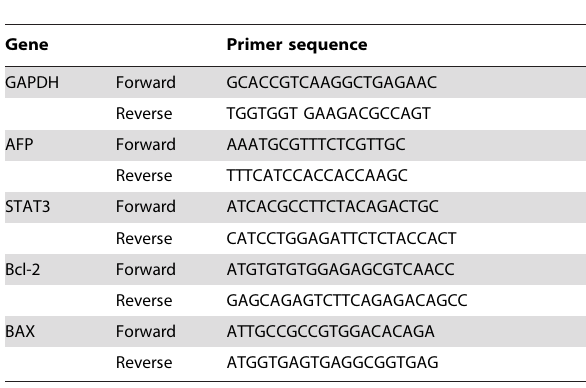
Table 1. Primer sequences for real-time